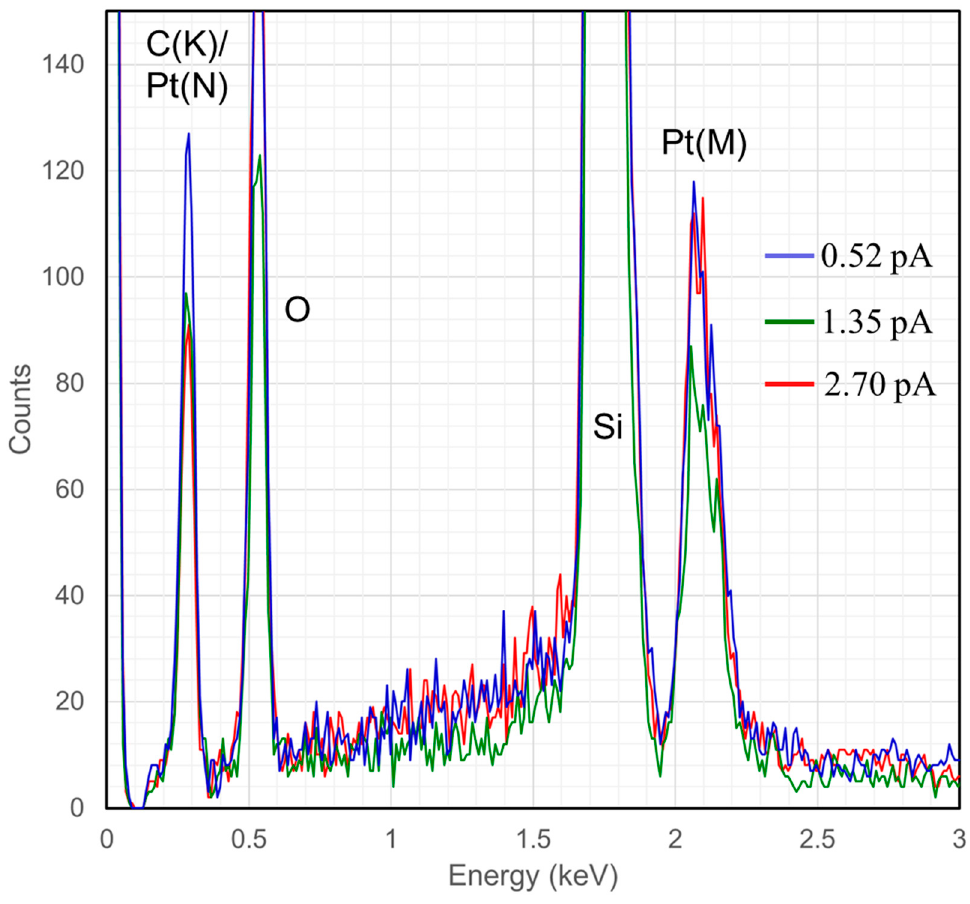
Figure 7. Energy dispersive X-ray spectroscopy (EDS) purity analysis of FIBID structures at three different currents. Blue = 0.52 pA, Green = 1.35 pA, Red = 2.70 pA .